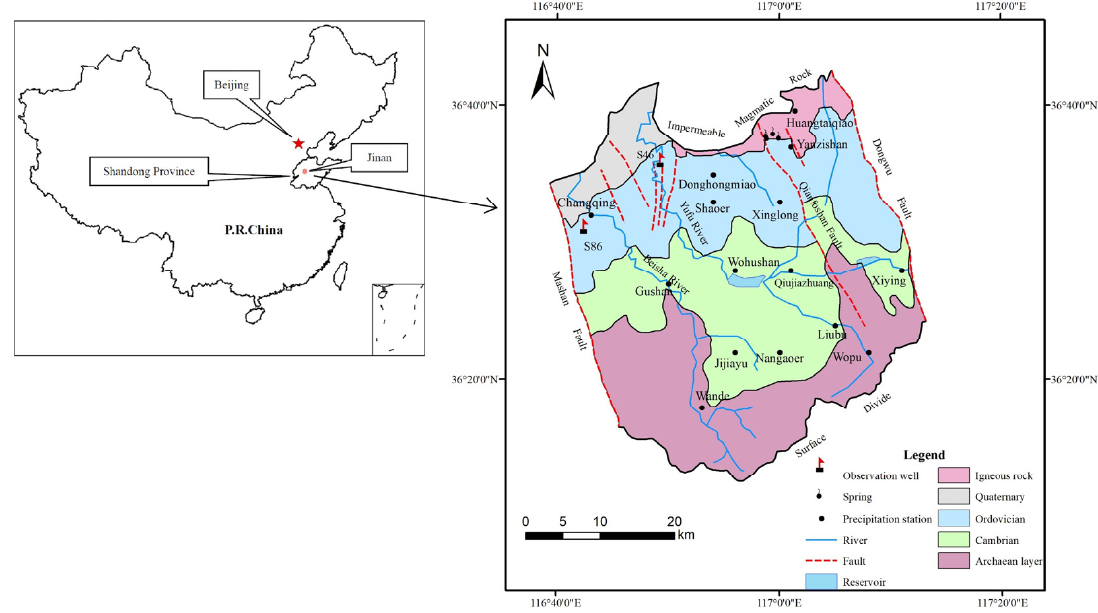
Figure 1. Distribution of precipitation stations in Jinan Spring Basin.